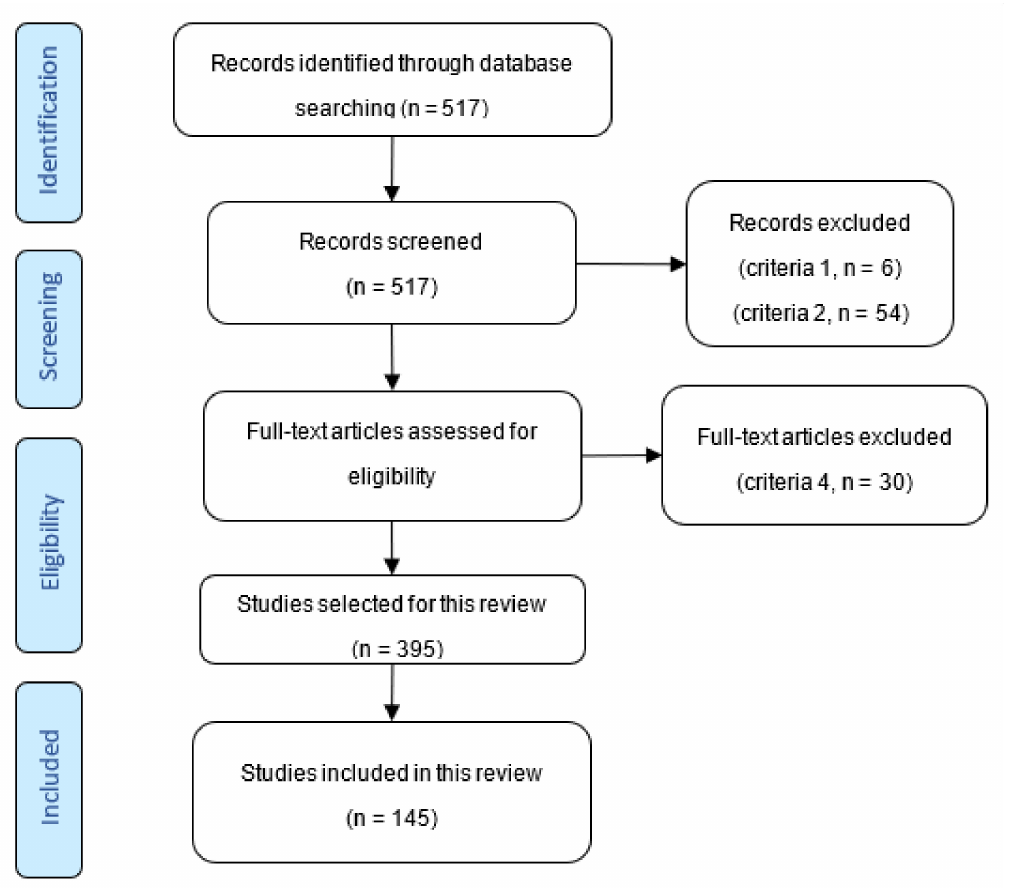
Figure 2. The Prisma flow diagram of the study selection